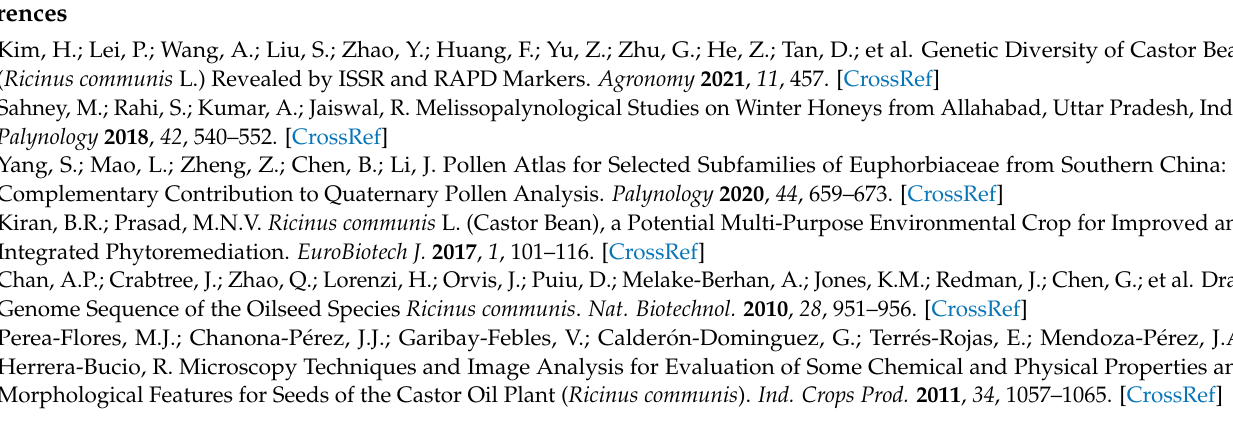
Table S2: Quantitative characteristics of abaxial leaf (AB) and adaxial leaf (AD) surface ultrastructure of Ricinus communis ; Table S3: One-way ANOVA of abaxial leaf and adaxial leaf surface ultrastructure characters of Ricinus communis ; Table S4: The one-way ANOVA of the soil traits showed non- significant variation for the three studied groups of Ricinus communis ; Table S5: The one-way ANOVA of the phytochemical concentration exhibited non-significant variation for the three studied groups of Ricinus communis